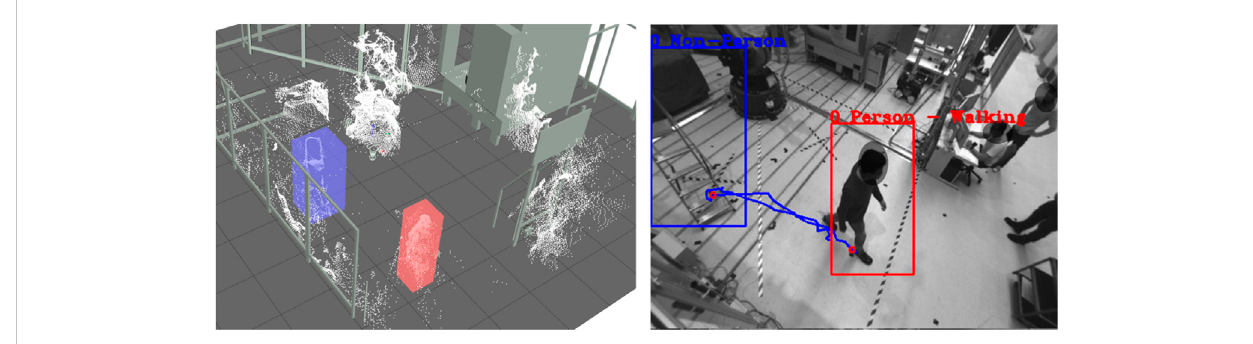
FIGURE 5 Results of the automatic annotation step visualized in the 3D workspace (left) and RGB image (right) of Sensor 1. People are marked with (red) and objects with